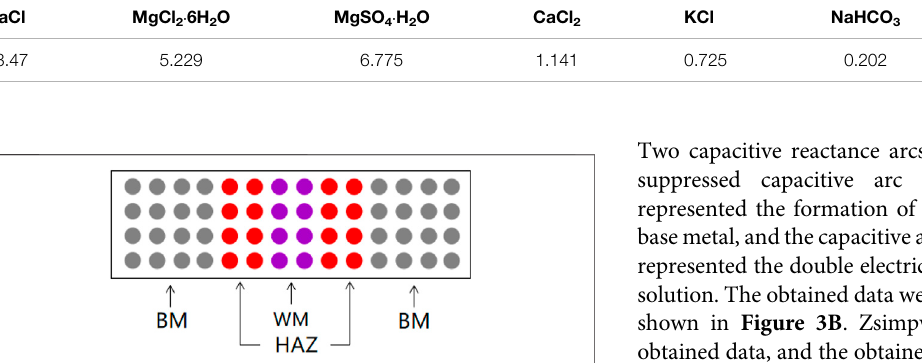
FIGURE 1 | Speci fi c arrangement of array